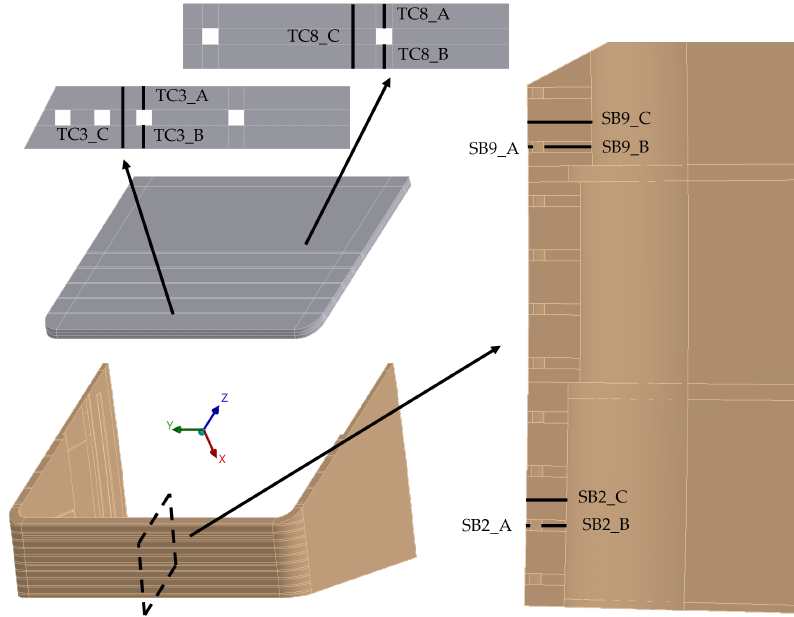
Figure 23. Paths considered within Eurofer domain for the stress